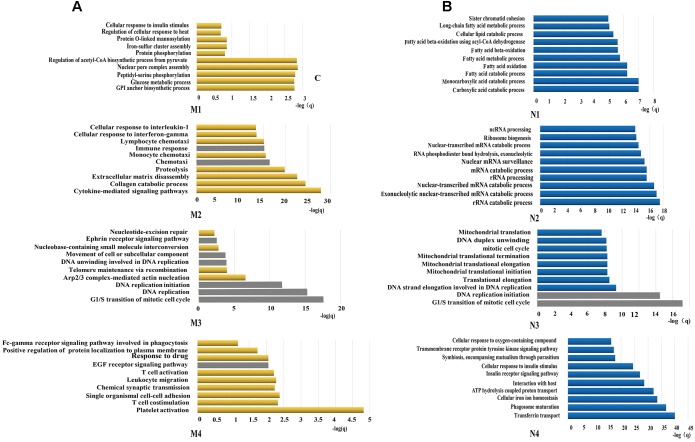
Functions predicted by the bioinformatic analysis. (A) Represents the top 10 predicted functions of P311 in modules from dataset 1. (B) Represent the top 10 predicted functions of P311 in modules from dataset 2. Gray squares stand for the predicted common functions.